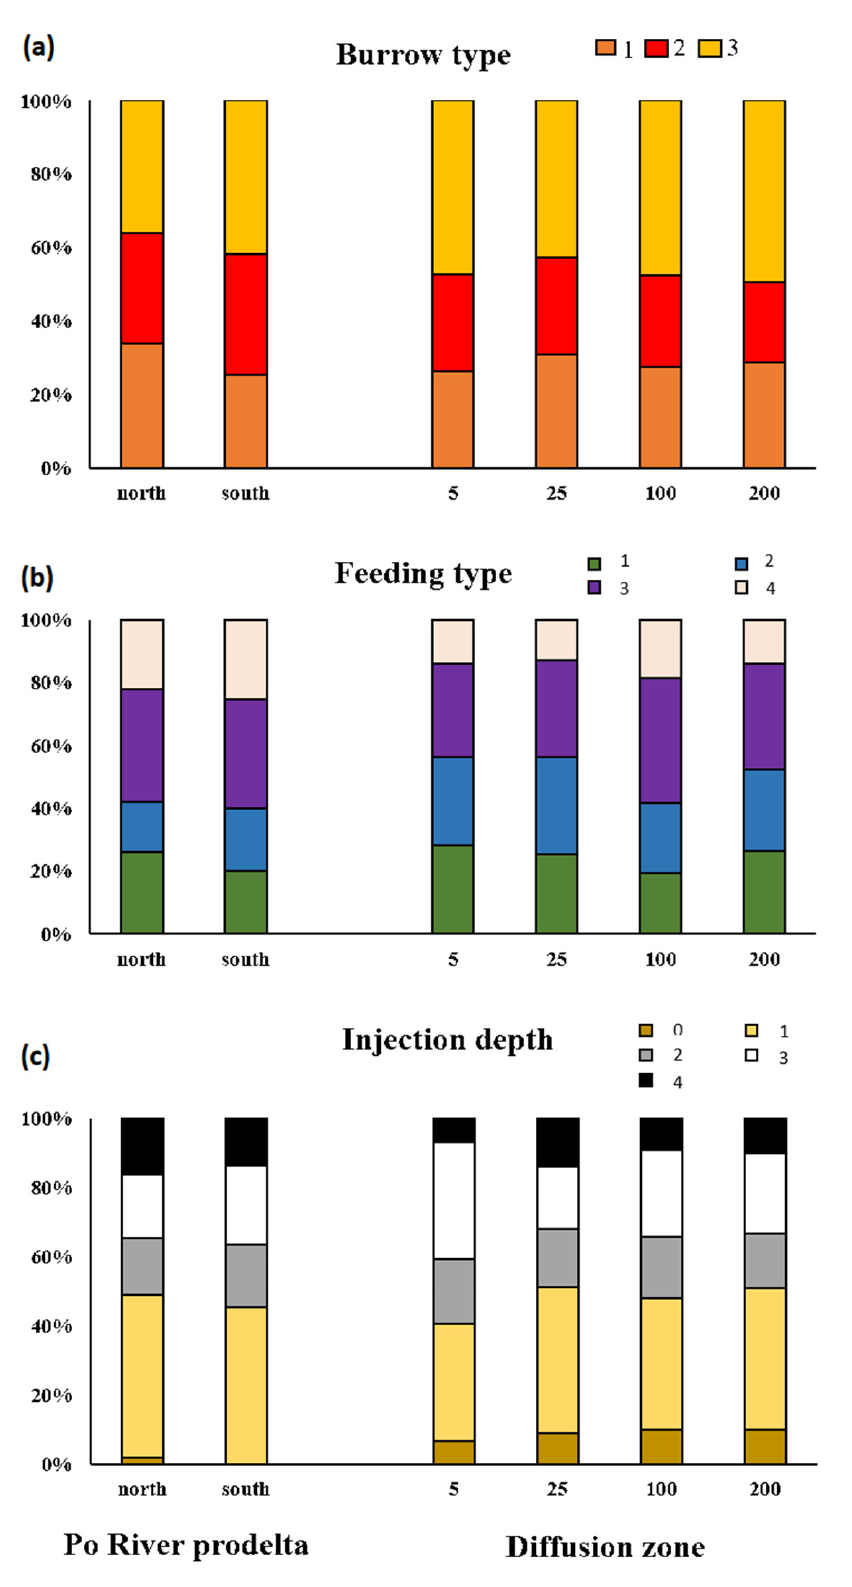
Figure 6. Relative frequencies (%) of scores belonging to burrow type ( a ), feeding type ( b ), and injection depth ( c ) of bio-irrigation activities of community at north and south for Po River coastal area and at increasing distance from pipelines (<5, 25, 100, and >200 m) in the Gulf of Trieste. See Table S2 for scores.